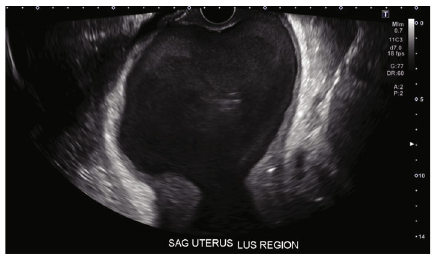
Figure 2: Transvaginal sagittal view of the vagina, cervix, and lower uterine segment.